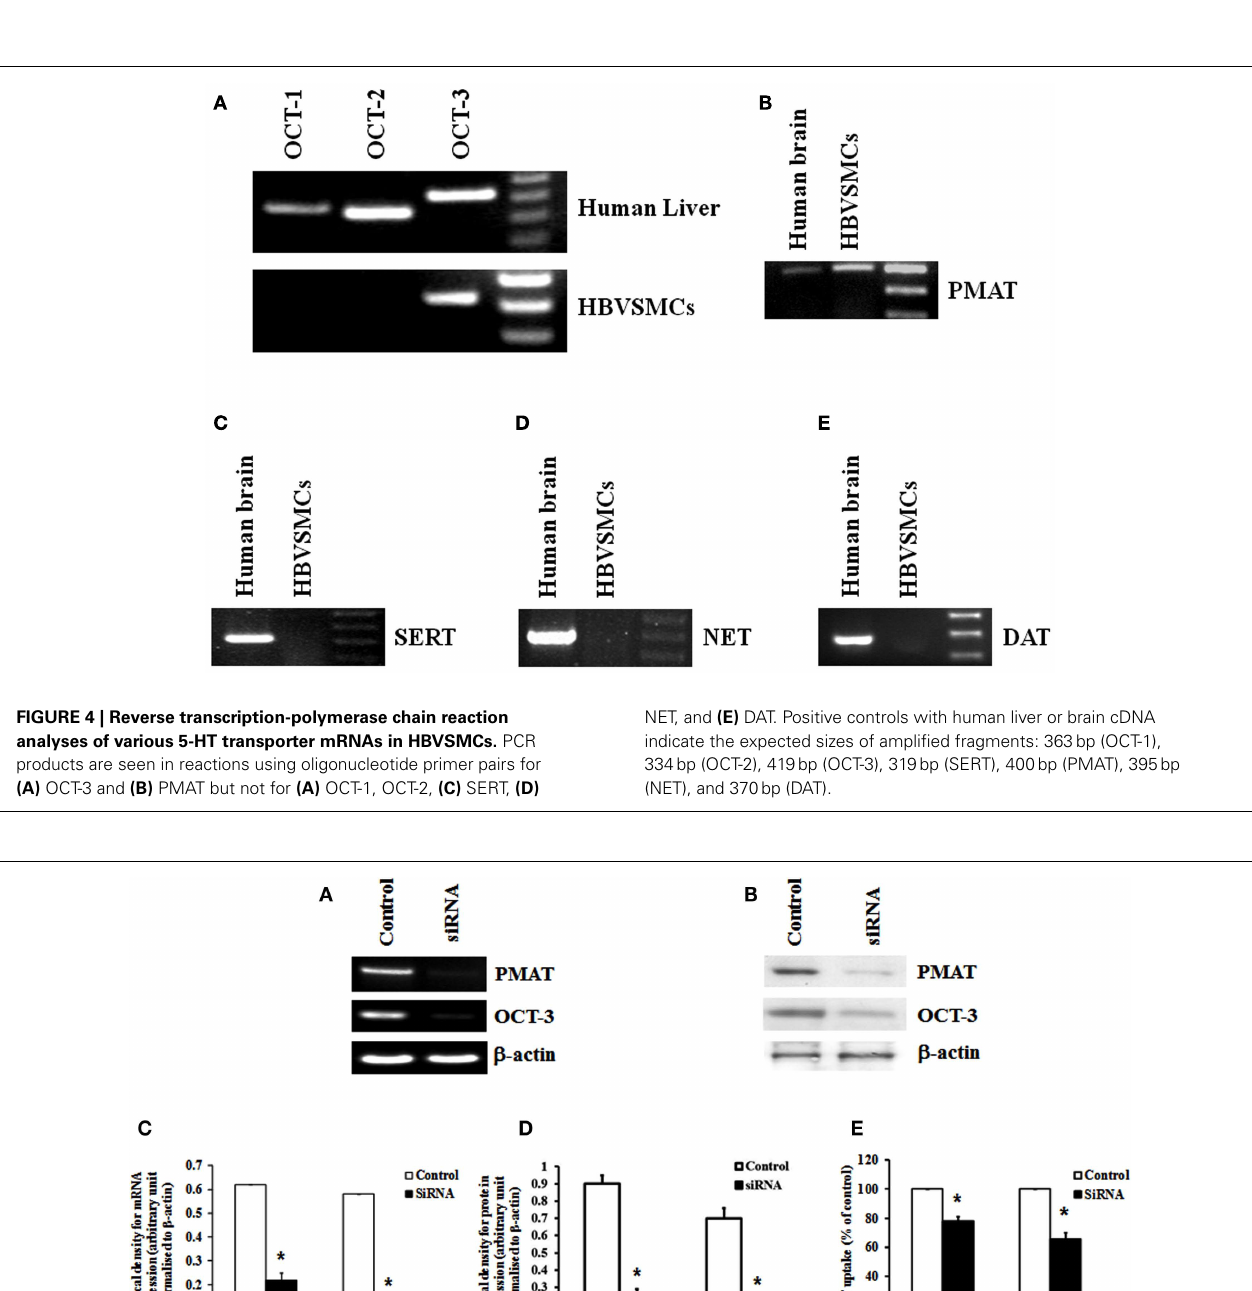
mRNA and (D) protein of OCT-3 and PMAT normalized to β -actin. (E) 5-HT uptake in HBVSMCs transfected with OCT-3 and PMAT siRNA and a control non-silencing sequence.Values are means ± SEM of three separate experiments. * P < 0.05 vs.